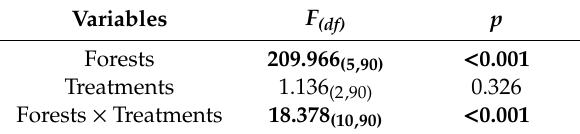
Table A1. The effects of forest type (5 forest types and 1 nonforest), soil treatments (original soil, activated carbon addition, and soil sterilization), and their interactions on the total biomass of Phytolacca americana, based on two-way ANOVA. Degrees of freedom are indicated as subscripted numbers in parentheses after the F-value. Statistically significant values ( p < 0.05) are denoted by bold font.